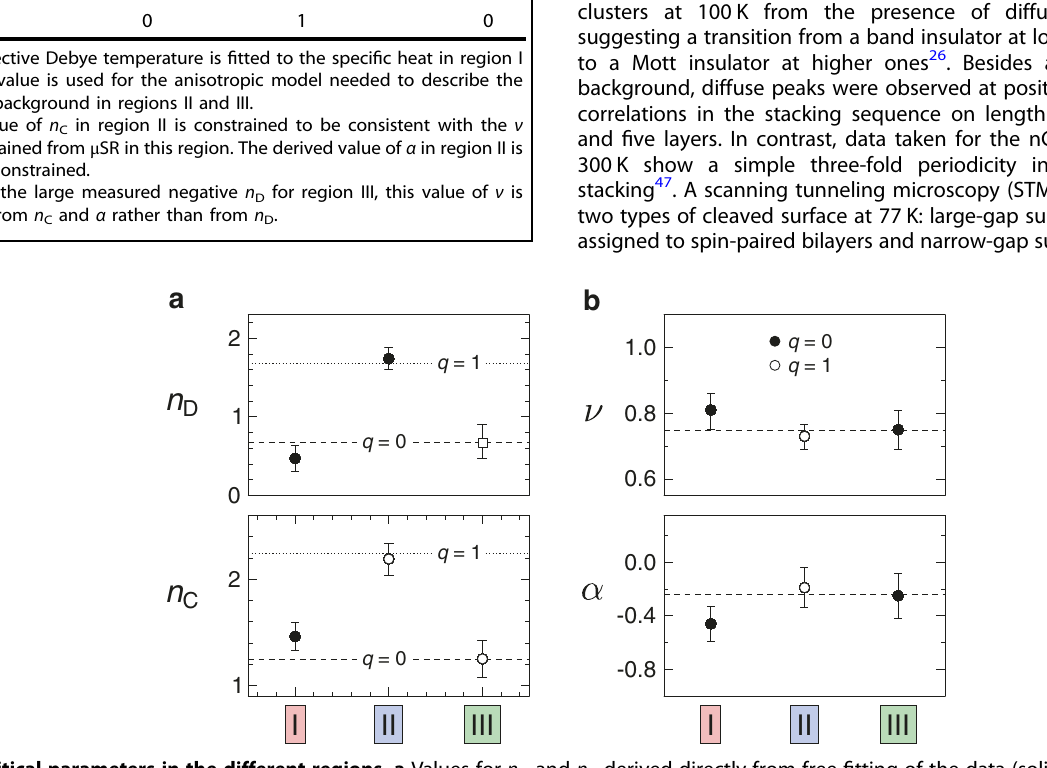
Fig. 5 Critical parameters in the different regions. a Values for n D and n C derived directly from free fi tting of the data (solid circles). Values for n C in regions II and III obtained by a fi t constraining n C in region II to be consistent with n D in region II (open circles). The open square for region III shows the n D value that would be consistent with the n C obtained in the same region. The measured n D in this region at − 4(1) deviates strongly from this value. Dashed and dotted lines show O(4) model values for q = 0 and q = 1. b The self-consistent set of derived critical exponents compared with the O(4) model values, shown as dashed lines. Open and closed symbols indicate the q values found for each region. Error bars indicate standard errors of the fi tted